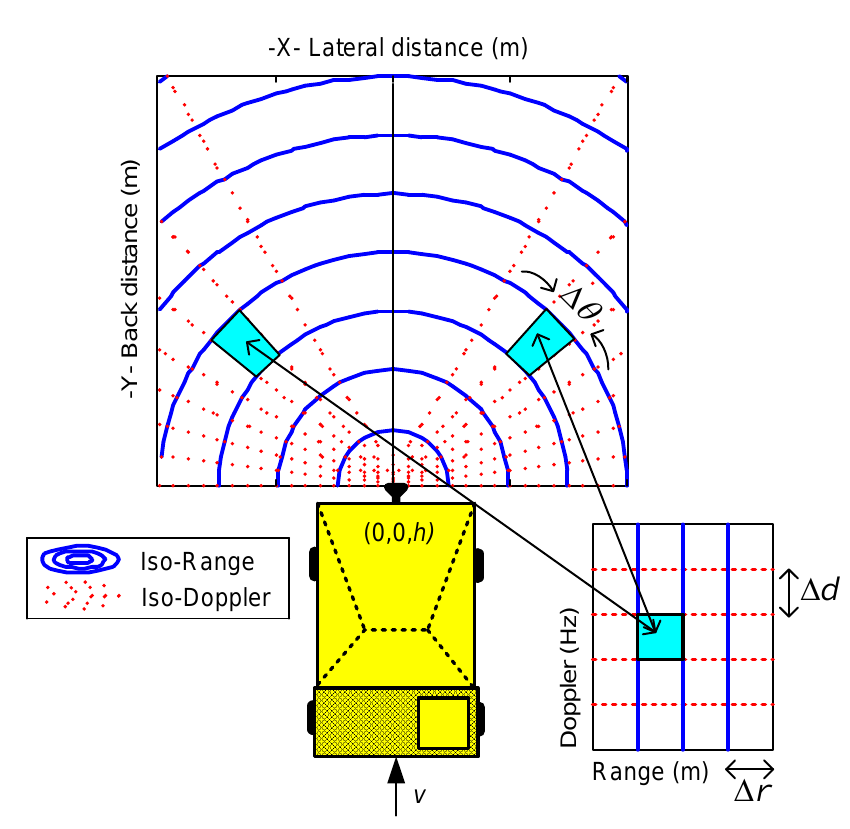
Figure 3. Range-Doppler mapping of the ground